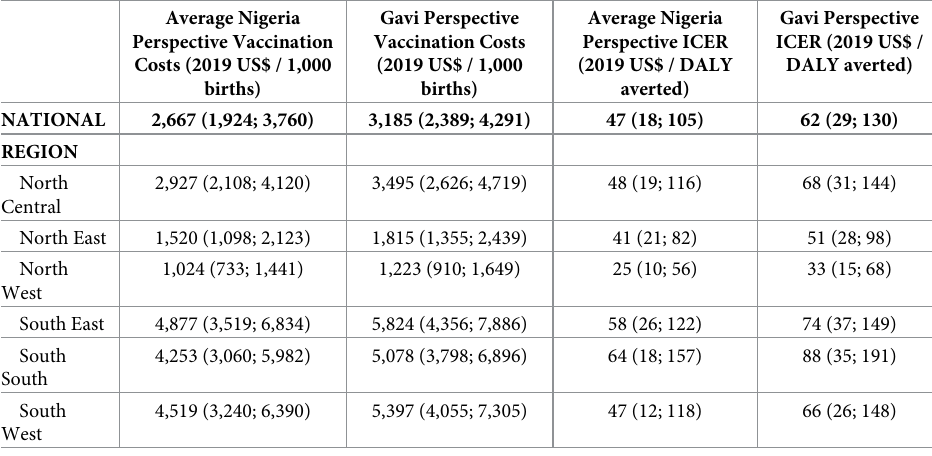
Table 6. Estimated national and regional vaccination costs and cost-effectiveness of rotavirus vaccine introduc- tion in a cohort of children in Nigeria over the first five years of life. ‘Average Nigeria perspective’ incremental cost-effectiveness ratio (ICER) base case estimates assumed Gavi subsidies for the first 5 years of vaccine introduction. ‘Full price’ is the cost of the vaccine from the perspective of